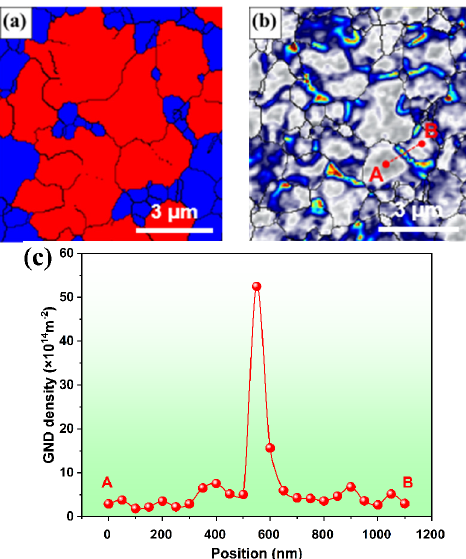
Figure 5. ( a ) Recrystallization area distribution of the alloy annealed at 600 ° C and ( b ) its corresponding GND density distribution; ( c ) line distribution of GND density of line A to B in ( b ).